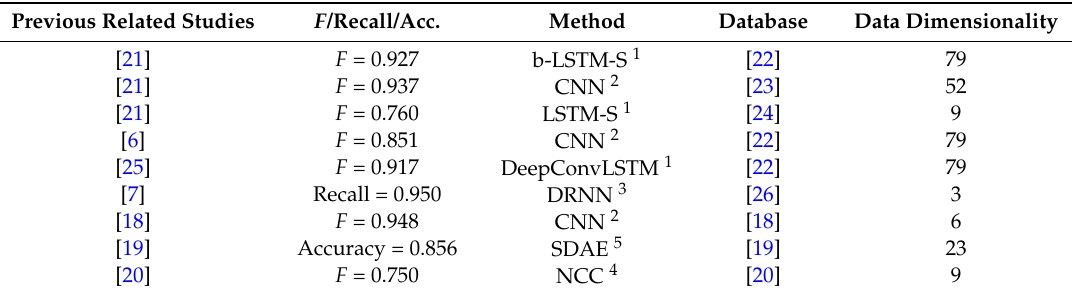
Table 2. Best results in similar previous